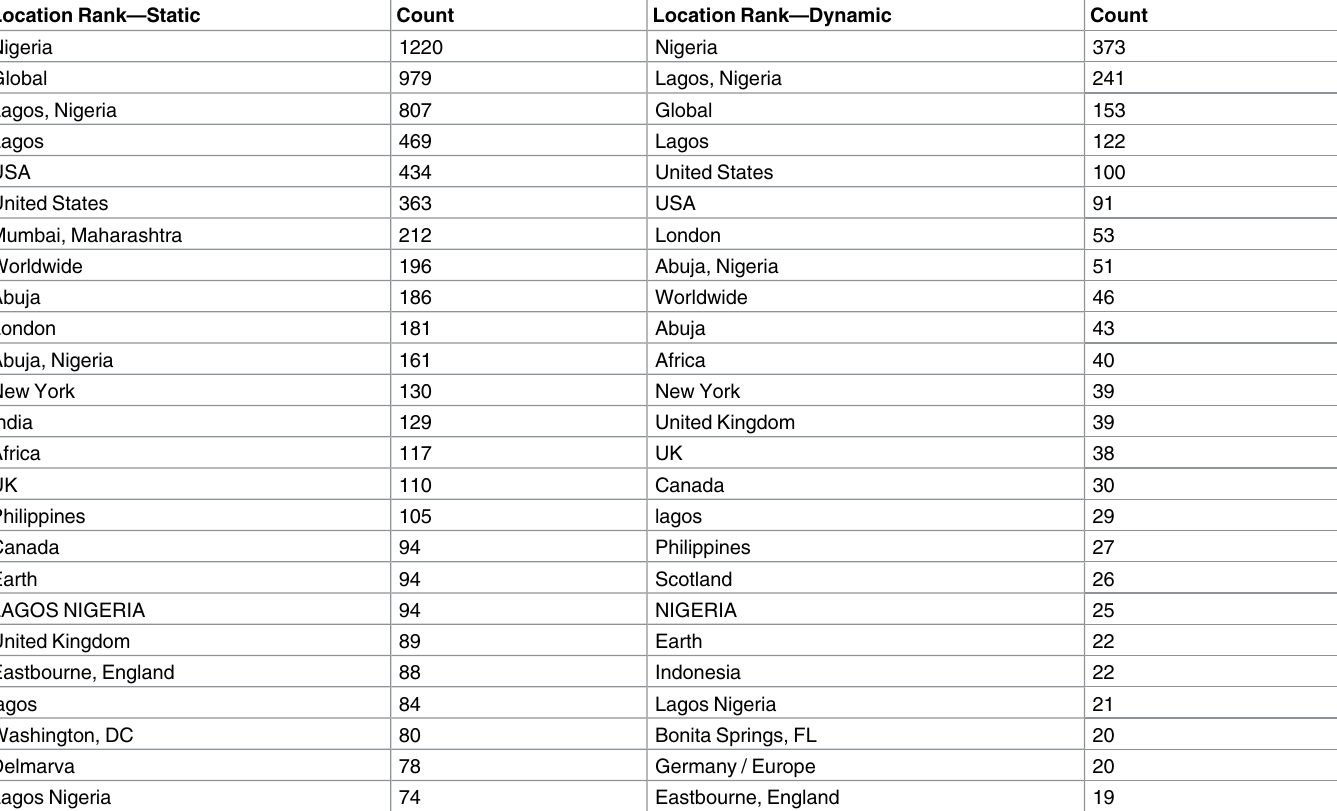
Table 6. Top ranking locations based on profile of account for static and dynamic outbreak AI-related Tweets. Location